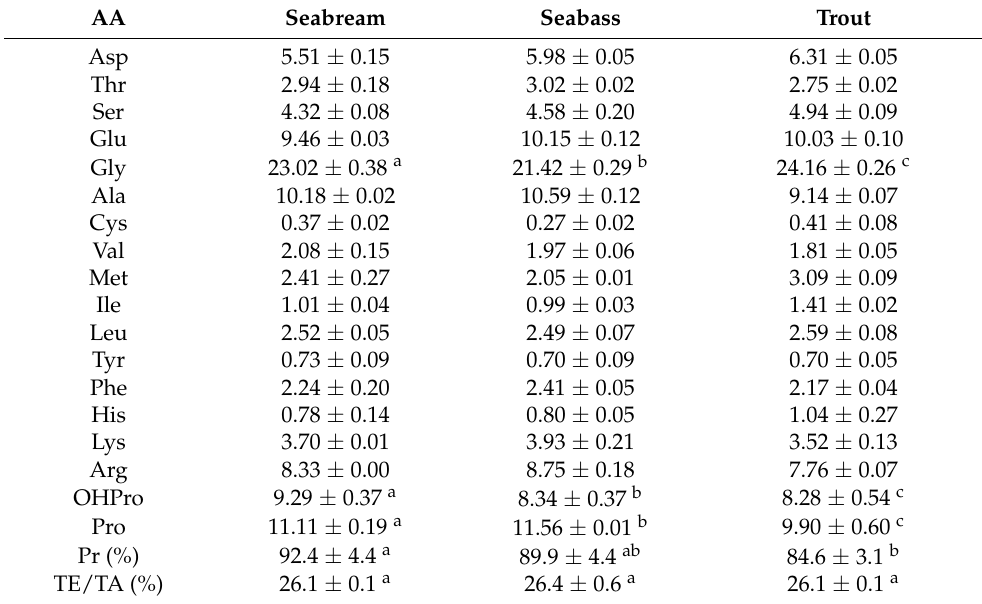
Table 2. Amino acid (AA) content of gelatins recovered from fresh aquaculture fish skins (% or g/100 g total amino acids) with each protocol of production. OHPro: hydroxyproline. Pr: % of protein present, as the sum of amino acids, in the extracted gelatin sample. TE/TA: ratio total essential amino acids for human/total amino acids. Errors are the confidence intervals for n = 2 (replicates of independent batches) and α = 0.05. Different superscript letters in each row mean statistically significant differences between fish species ( p <